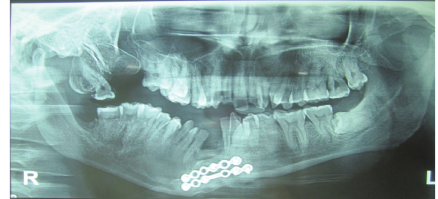
Figure 7: Postoperative orthopantomogram.